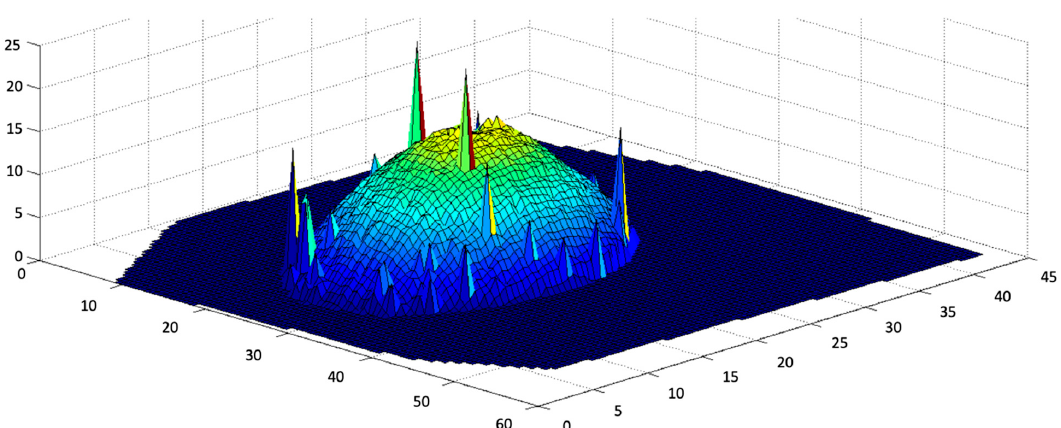
Figure 19. The 3D reconstructed image of the mango using the line laser scanner developed by Illionix LLC. The error spikes on the top surface of the mango can be eliminated by error catching; however, this system is limited in scanning the sides of the object since the scanner only scans from the top view angle.